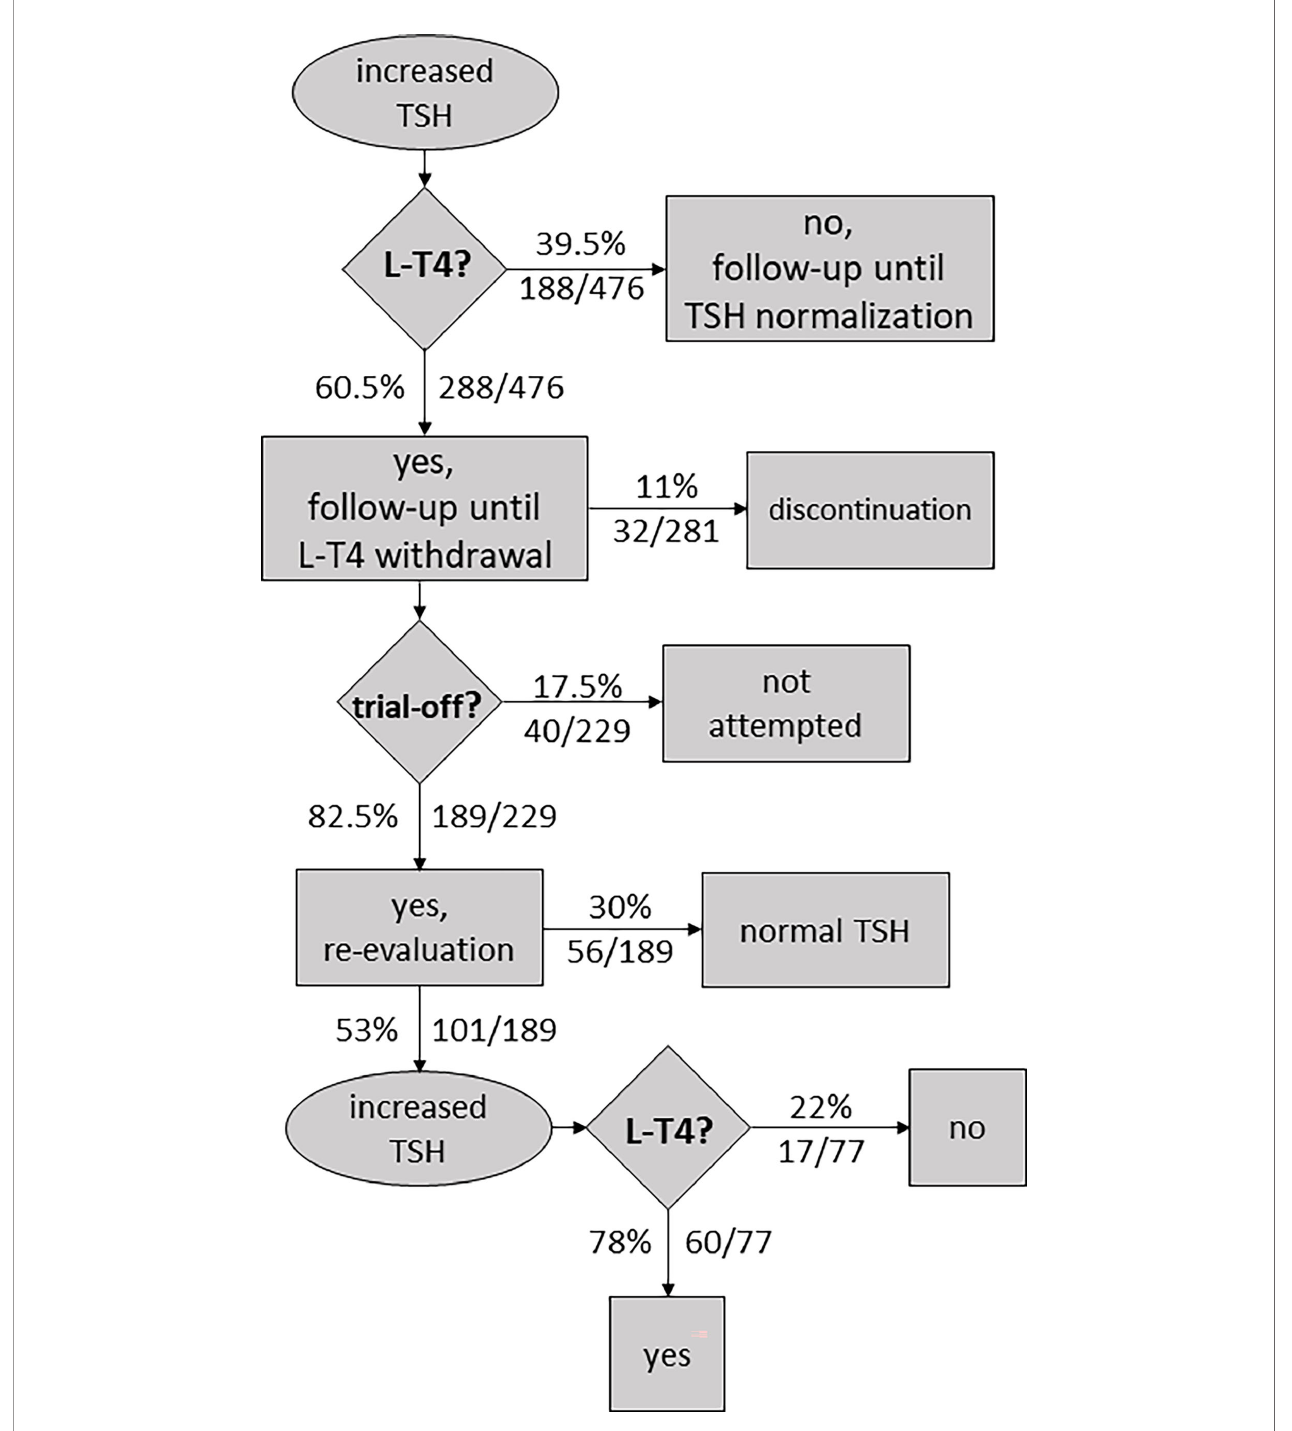
FIGURE 4 | Flowchart illustrating an approach to the management of neonatal hyperthyrotropinemia based on the reviewed